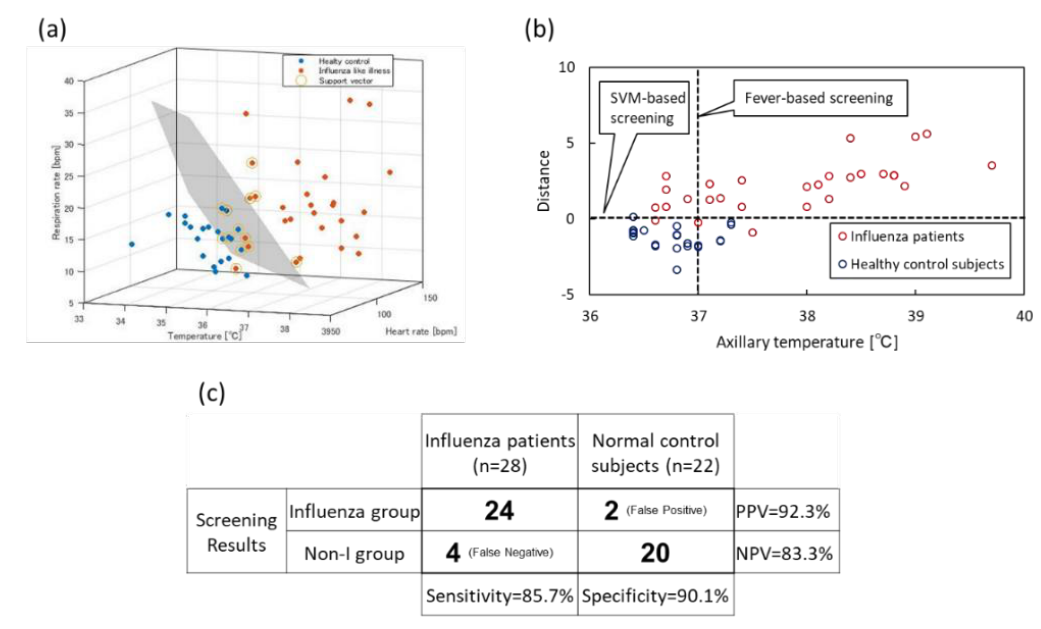
Figure 11. Classification model based on Support Vector Machine (SVM). ( a ) SVM classification. ( b ) Confusion matrix.